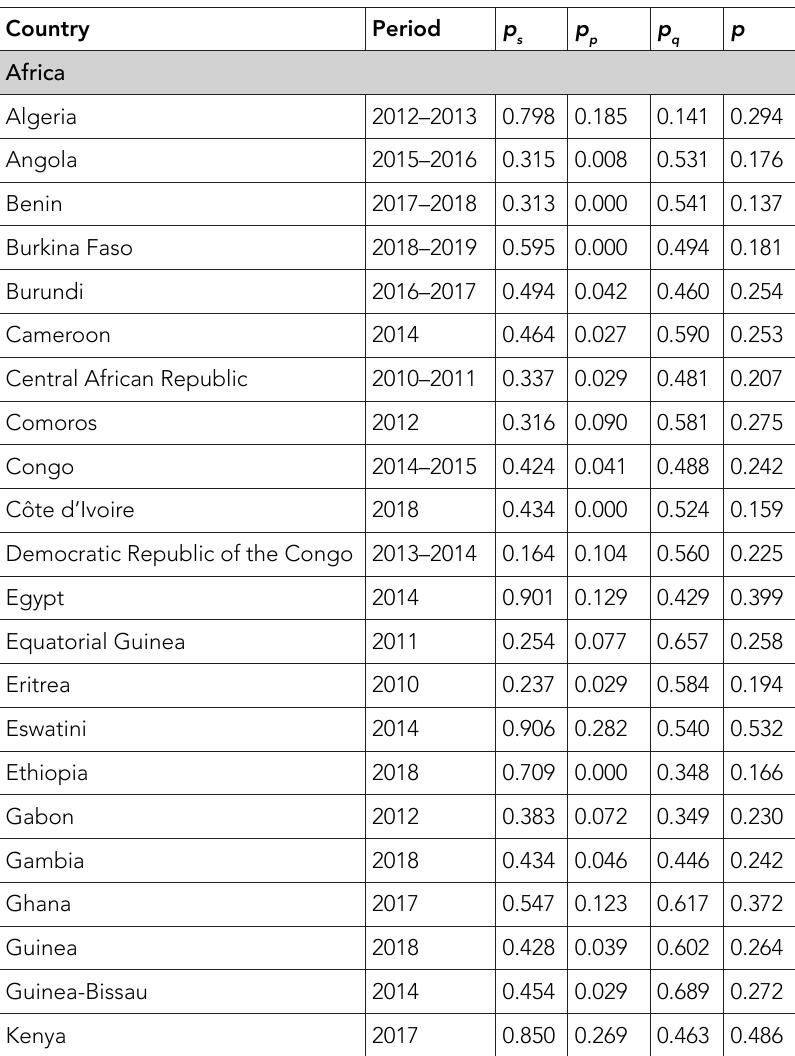
Appendix Table 1: Indicators of Family Planning Progress in 113 countries, Latest Available